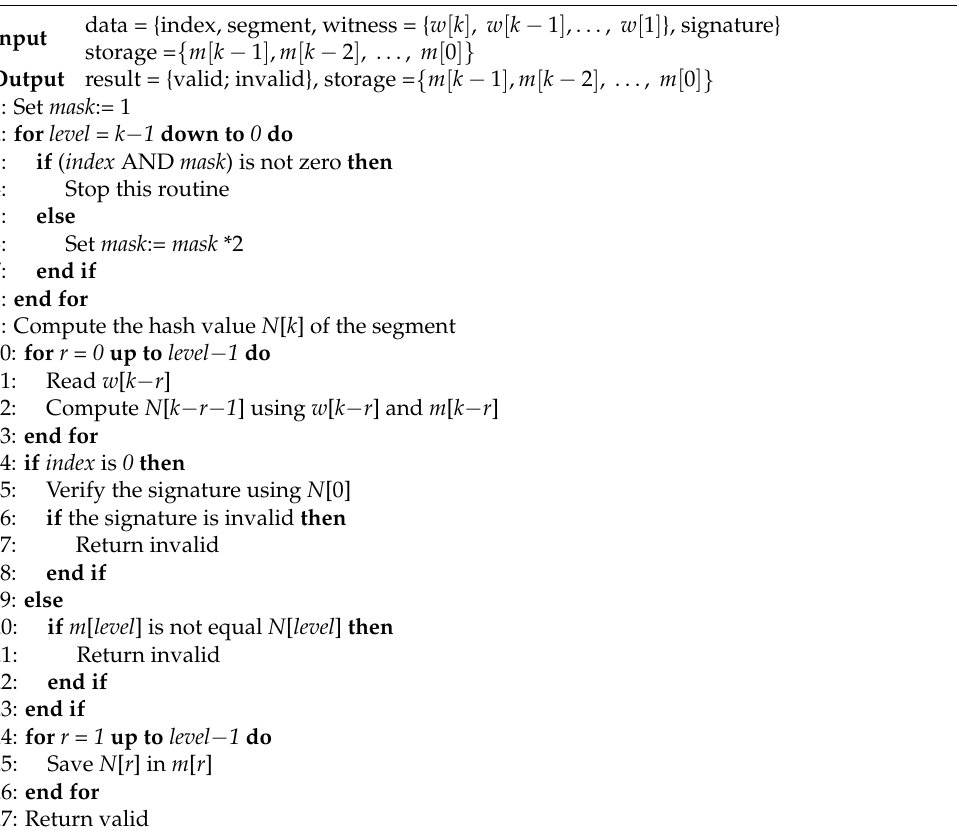
Algorithm 1 : Pseudo code for verifying a segment (Proposal